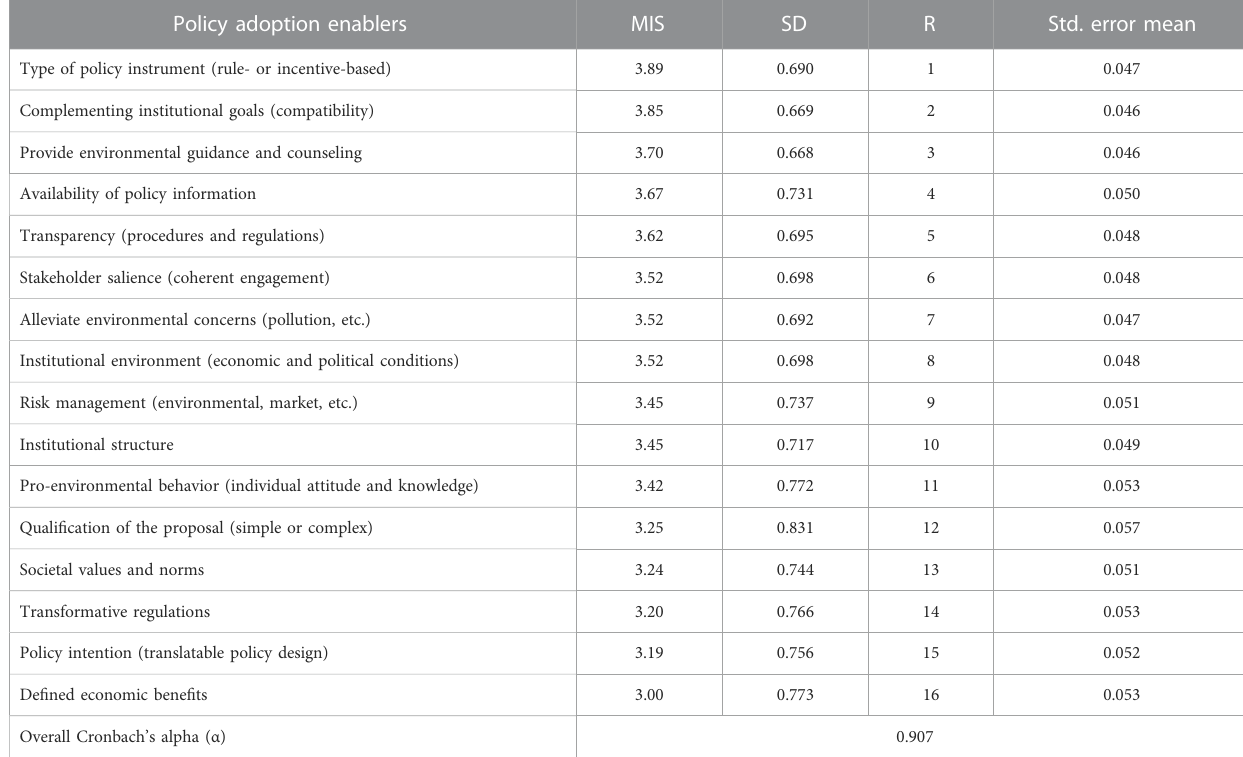
TABLE 3 Environmental policy adoption descriptive